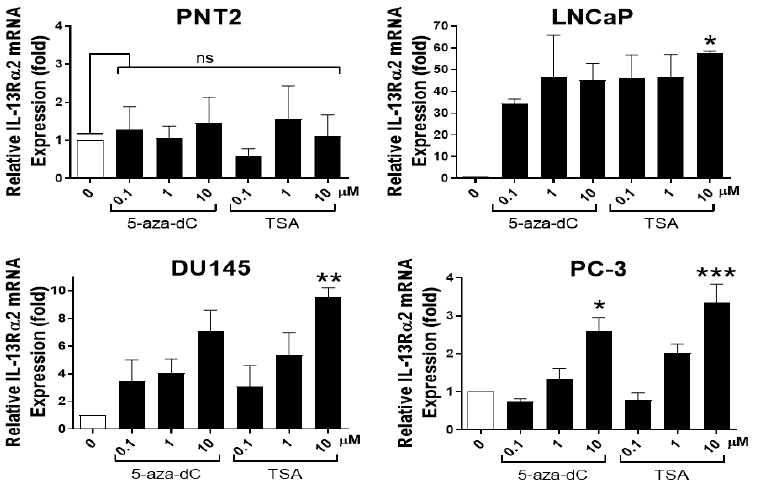
Figure 10. Analysis of IL-13R α 2 mRNA expression in 3D prostate cell lines treated with TSA and 5- aza-dC via RT-PCR. RT-PCR analysis of IL-13R α 2 expression in various prostate cell lines treated with 0.1, 1 and 10 µM of TSA and 5-aza-dC for 24 h. The data represent mean ± SEM (error bars represent SEM) of three independent experiments. All RT-PCR values were normalised to housekeeping controls. IL-13R α 2 mRNA levels in cancer cells were compared to those in the PNT2 non-cancer cell line control (* p < 0.05; ** p < 0.01; *** p < 0.001; ns, not significant). 3.10. The Cytotoxic Effect of Pep-1-Phor21 on Prostate Cell Spheroids Treated with TSA and 5- aza-dC